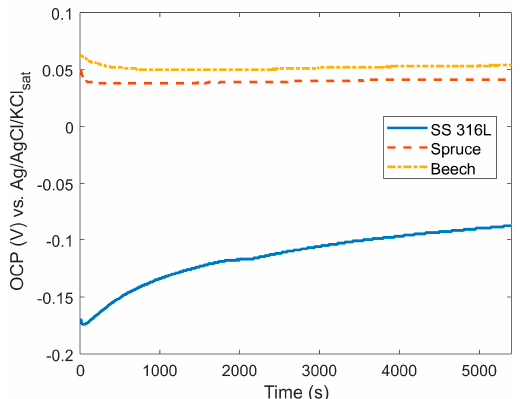
Figure A5. Open circuit potential (OCP) of samples as a function of time after immersion in SBF solution.